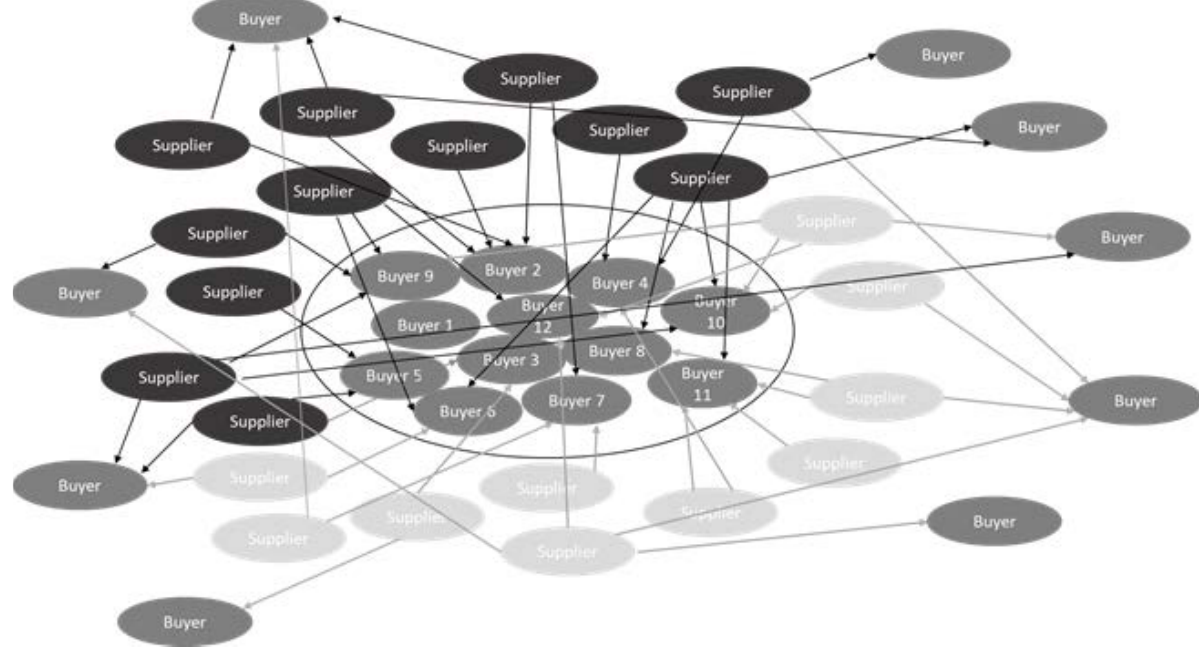
Figure 1. HSEQ cluster supplier–buyer network illustrations. Buyers 1–12 in the middle are the cluster buyer companies, and the highlighted suppliers are the strategic